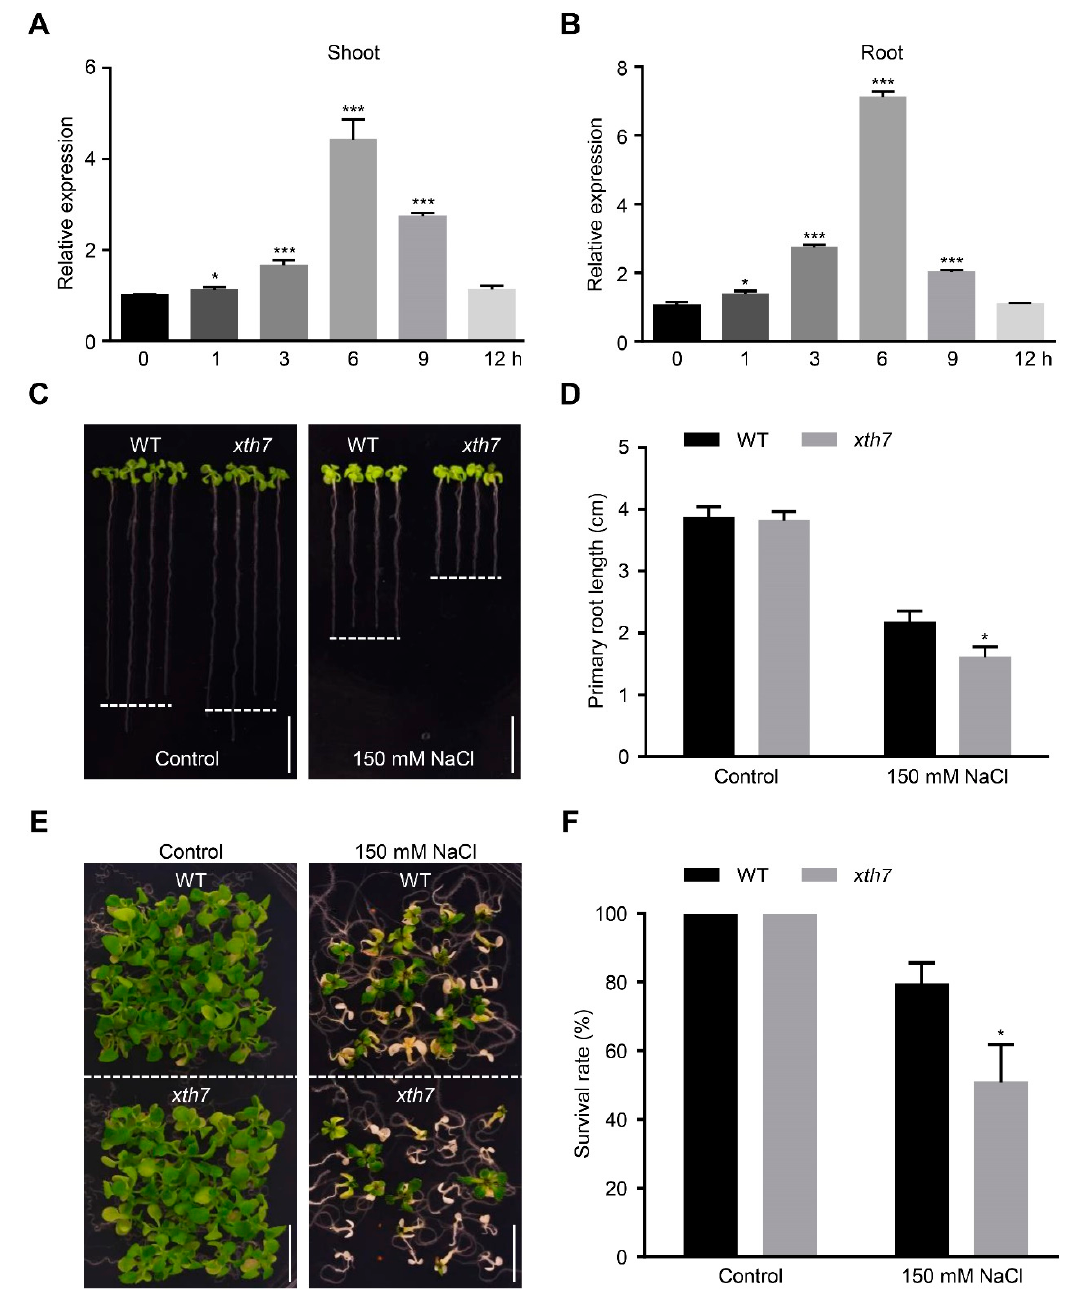
Figure 5. The xth7 mutant is sensitive to salt stress. ( A ) Responsiveness of shoot XTH7 to salt stress. ( B ) Responsiveness of root XTH7 to salt stress. In ( A , B ), 7-day-old seedlings were treated with 200 mM NaCl for 0, 1, 3, 6, 9 and 12 h. The data were normalized against the expression of GAPDH and UBQ10 . The bars indicate means ± sd of three independent replicates and are compared with the no-treatment condition (0 h). * p < 0.05, *** p < 0.001 (Student’s t test). ( C ) Photographs of WT and xth7 seedlings grown vertically on control or salt-containing medium. Three-day-old WT and xth7 seedlings grown on 1/2 MS medium were transferred to 1/2 MS medium with or without 150 mM NaCl for another 10 d. Scale bar = 1 cm. ( D ) Primary-root length of the seedlings in (C). ( E ) Photographs of three-week-old WT and xth7 seedlings grown on 1/2 MS medium with or without 150 mM NaCl. Scale bar = 1 cm. ( F ) Survival rate of the seedlings in ( E ). The bars indicate means ± sd of three independent replicates. * p < 0.05 (Student’s t test).